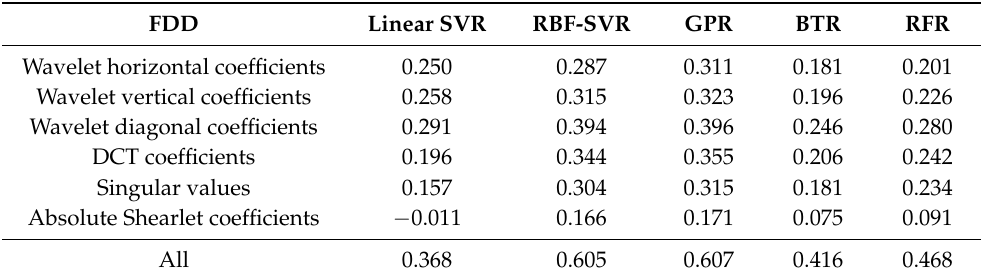
Table 6. Comparison of different FDD feature vectors extracted from different domains and different regression modules on KADID-10k [42] database. Median SROCC values were measured over 1000 random train–test splits.